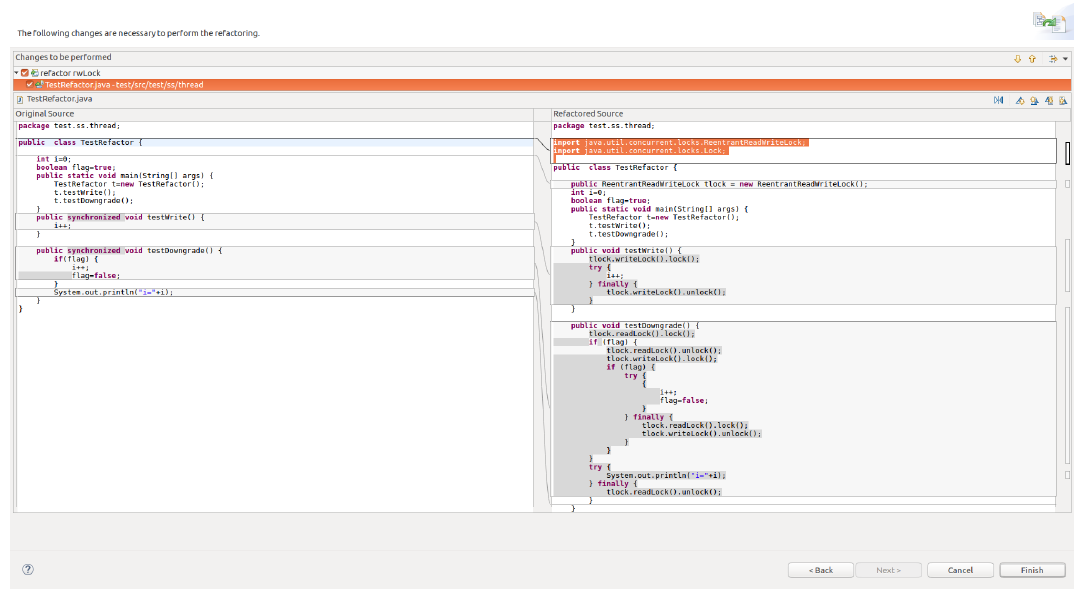
Figure 8. Screenshot of the refactoring